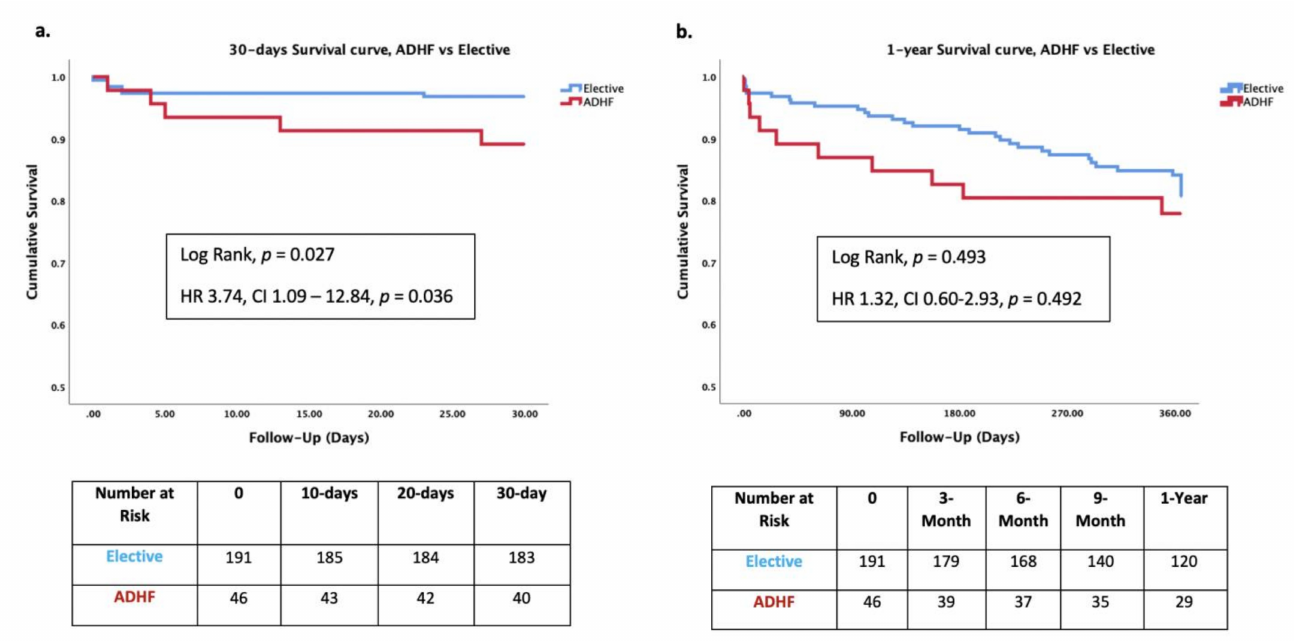
Figure 2. Kaplan–Meier survival analysis of 237 patients who underwent PMVr for severe MR between 2015 and 2020 by the ADHF group and elective patients. p -value for log rank test. ( a ). 30-day analysis. (b ). One-year analysis. PMVr = percutaneous mitral valve repair; ADHF = acute decompensated heart failure; MR = mitral regurgitation.